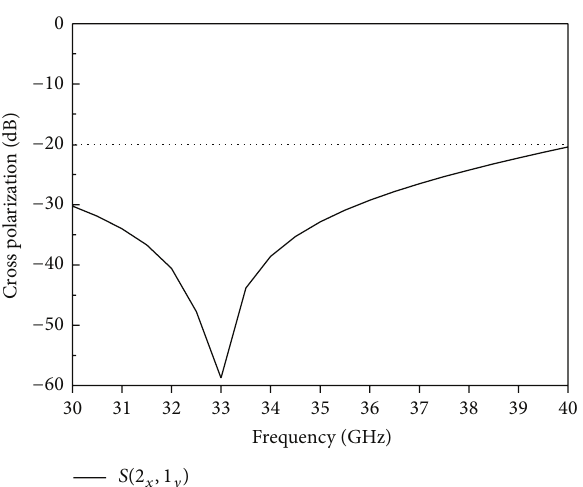
Figure 3: Simulated cross polarization performance of the hexagon loop PRS cell.